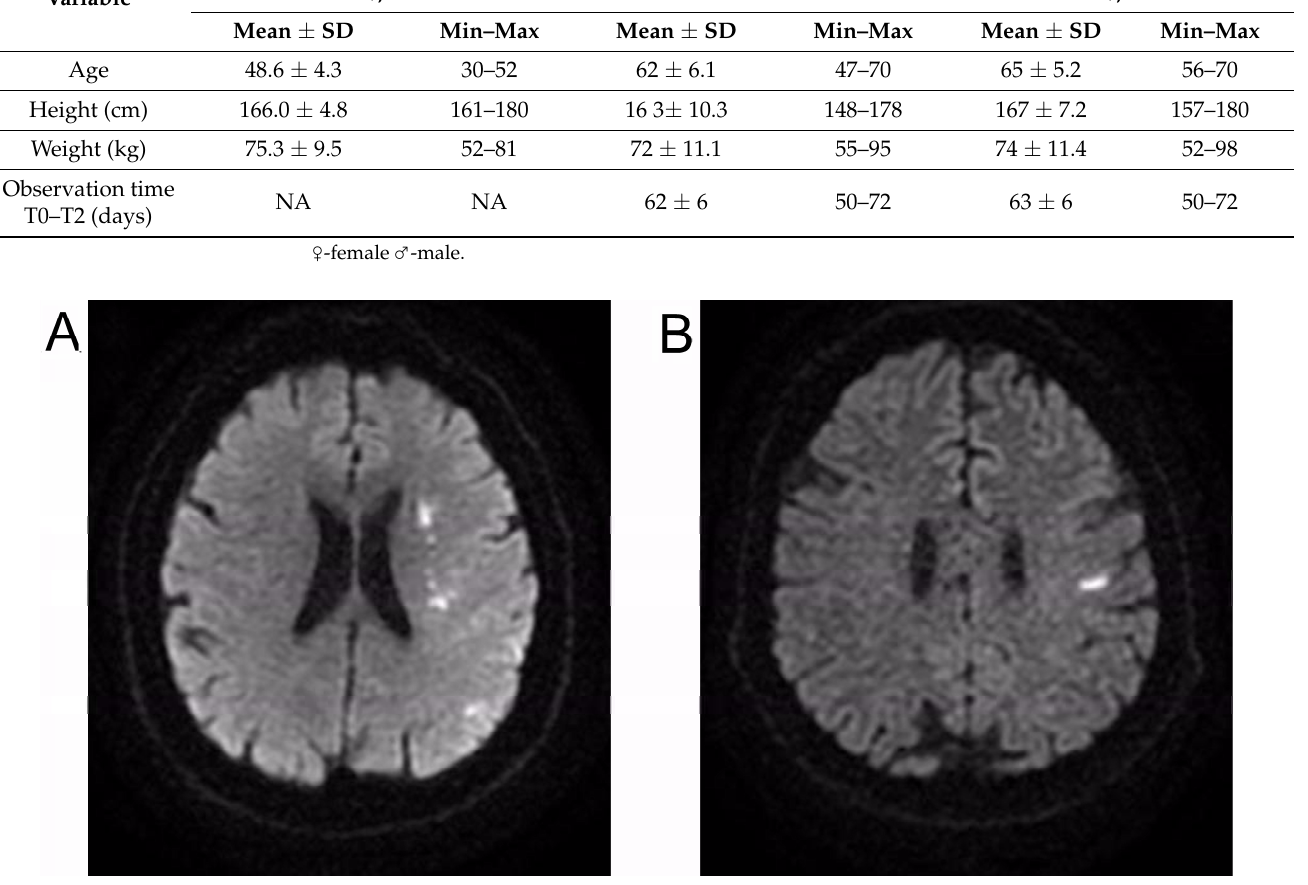
Figure 2. Examples of MRI pictures in DWI sequences presenting acute ischemic areas in patients from the NMFES+K group ( A ) and K group ( B ).